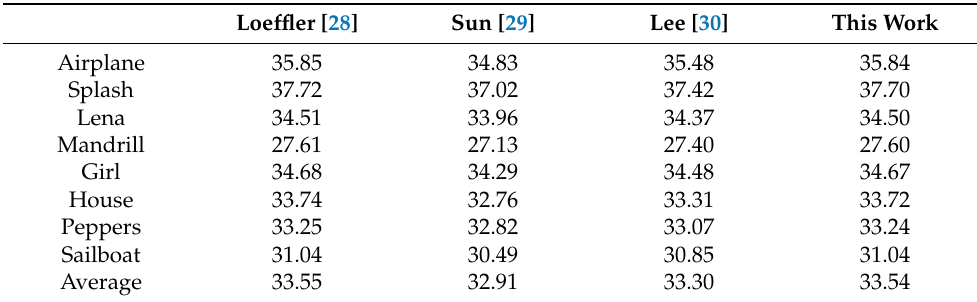
Table 3. Peak signal–noise ratio (PSNR) (dB) comparison of previous DCT algorithms and this work using the first image dataset shown in Figure 11.